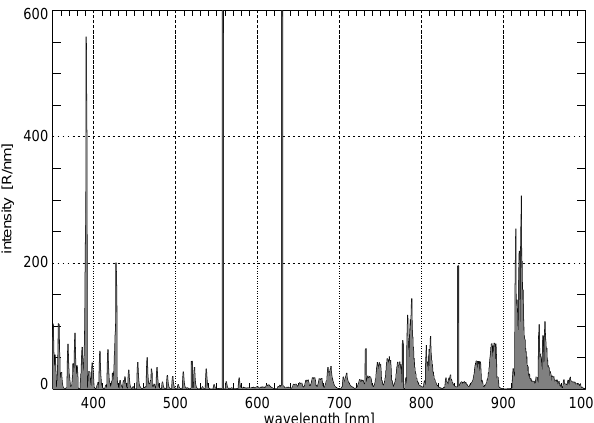
Figure 1. Auroral spectrum during low-activity geomagnetic and solar conditions for a beam of 1keV monoenergetic electrons with a total energy flux of 1mWm − 2 . Intensity range is clipped to dis- play spectral structure, 630.0nm red-line peak is approximately 810Rnm − 1 and 557.7nm, green line is 1190Rnm − 1